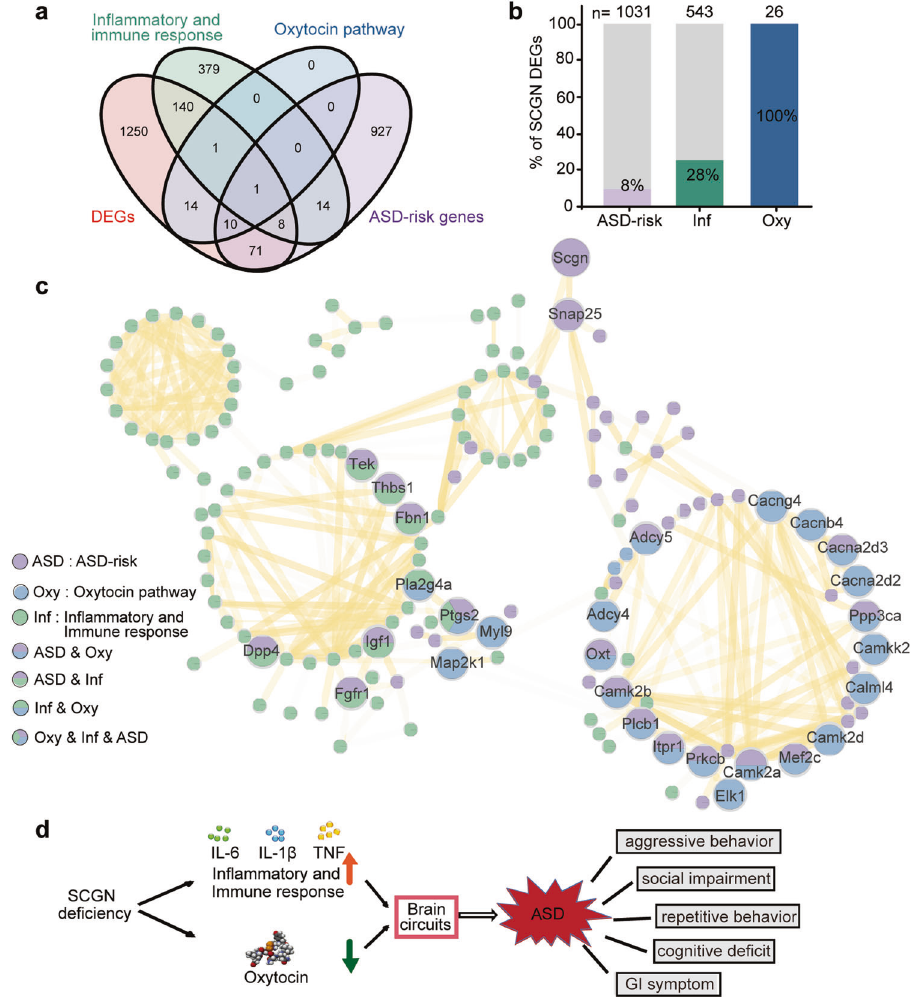
Fig. 8 SCGN connects oxytocin and immune response pathways with ASD. a Venn-diagram showing the overlap genes between four different gene sets: DEGs: the differentially expressed genes detected in Scgn − / − mice RNA-seq. In fl ammatory and immune response: the genes enriched in in fl ammatory and immune response by GSEA. Oxytocin pathway: the genes enriched in oxytocin pathway. ASD-risk genes: the genes related with ASD based on SFARI. b The number and ratio of SCGN DEGs associated with ASD, immune response, and oxytocin signaling pathway. 1495 genes that are differentially expressed in the brains of Scgn + / + and Scgn − / − mice are used for analysis. ASD-risk ASD- risk genes from the SFARI database (March 2022). Inf in fl ammatory and immune response, Oxy oxytocin pathway. N stands for the number of genes in the KEGG database. c The network representing protein interaction relationship between DEGs in ASD-risk, oxytocin pathway. in fl ammatory and immune response based on scgn − / − mice RNA-seq. The interaction con fi dence was fi ltered by 0.7. The line transparency indicated the degree of con fi dence. Purple dots represent ASD-risk genes, blue represent genes associated with the oxytocin pathway, green represent genes associated with in fl ammatory and immune responses, and the multicolor dots indicate overlap of function and pathway. d SCGN de fi ciency impairs oxytocin secretion and activates the in fl ammatory pathway, increasing the risk of ASD. Conversely, SCGN de fi ciency can be treated by administration of oxytocin and/or anti-in fl ammatory